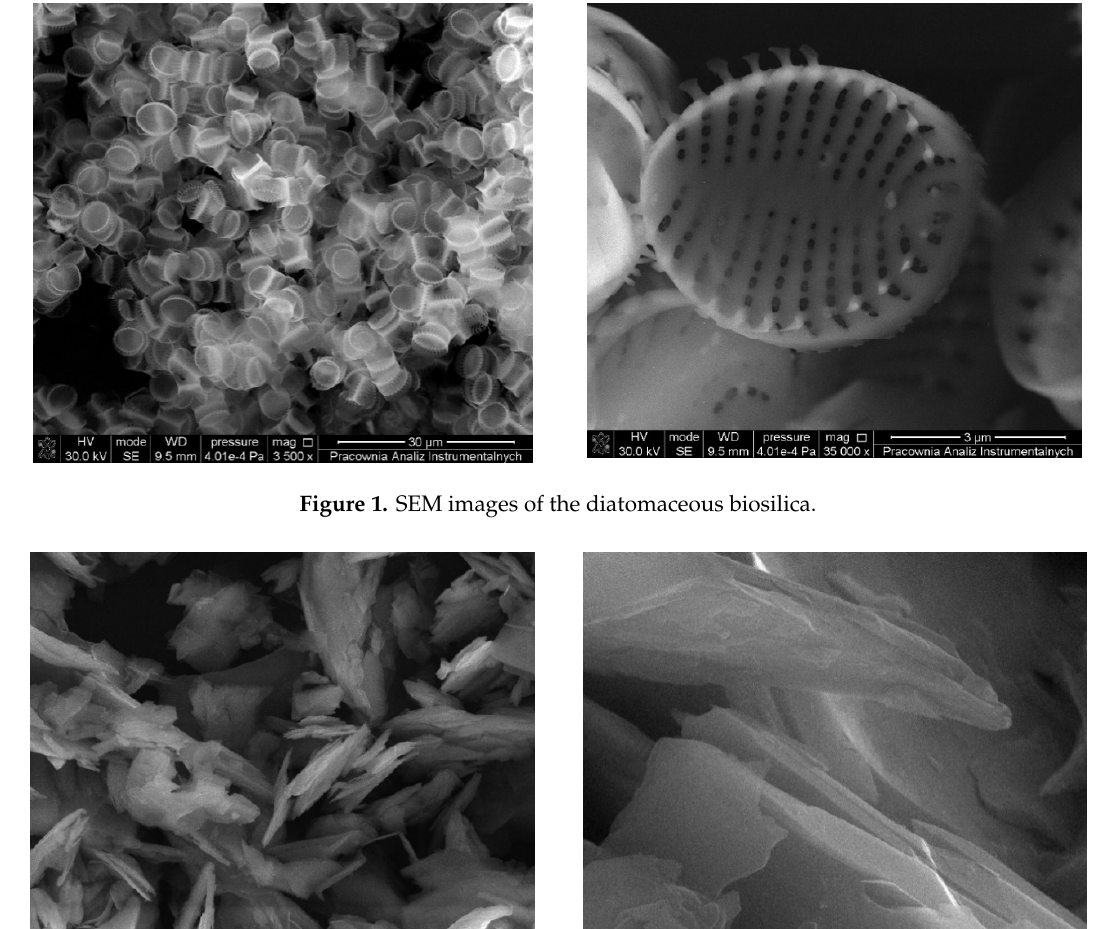
Figure 2. SEM images of the talc.